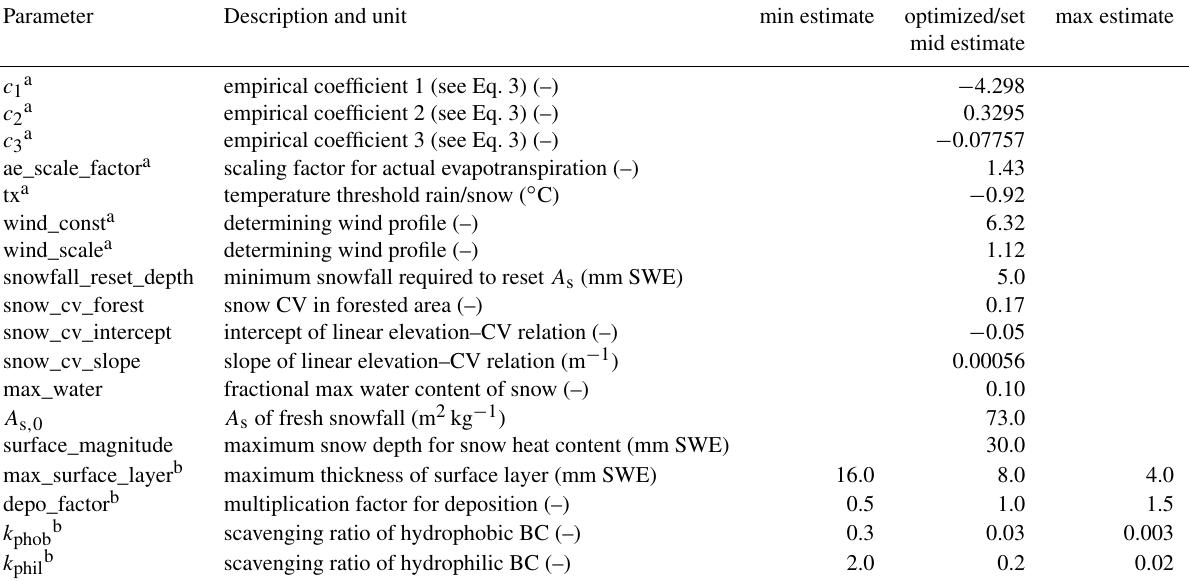
Table 2. Model parameters used in the sensitivity and case study. Parameters optimized during calibration are marked with a . Further parameters were pre-set and not included in parameter estimation during calibration. Parameters with different values in the minimum (min), central (mid), and maximum (max) BC radiative forcing estimates are marked with b